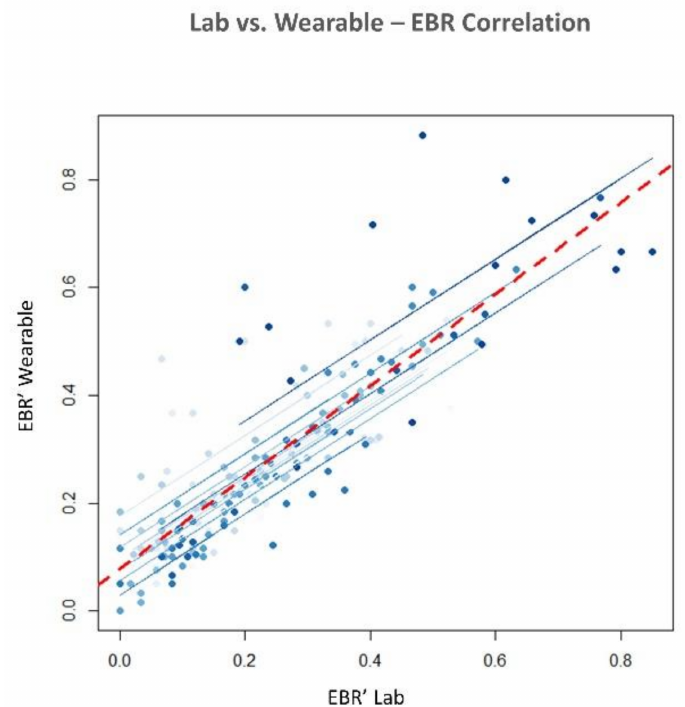
Figure 7. Pearson’s repeated measure correlation for the Eyeblink Rate (EBR) estimated with labora- tory and wearable devices. R = 0.83, p < 10 − 47 .